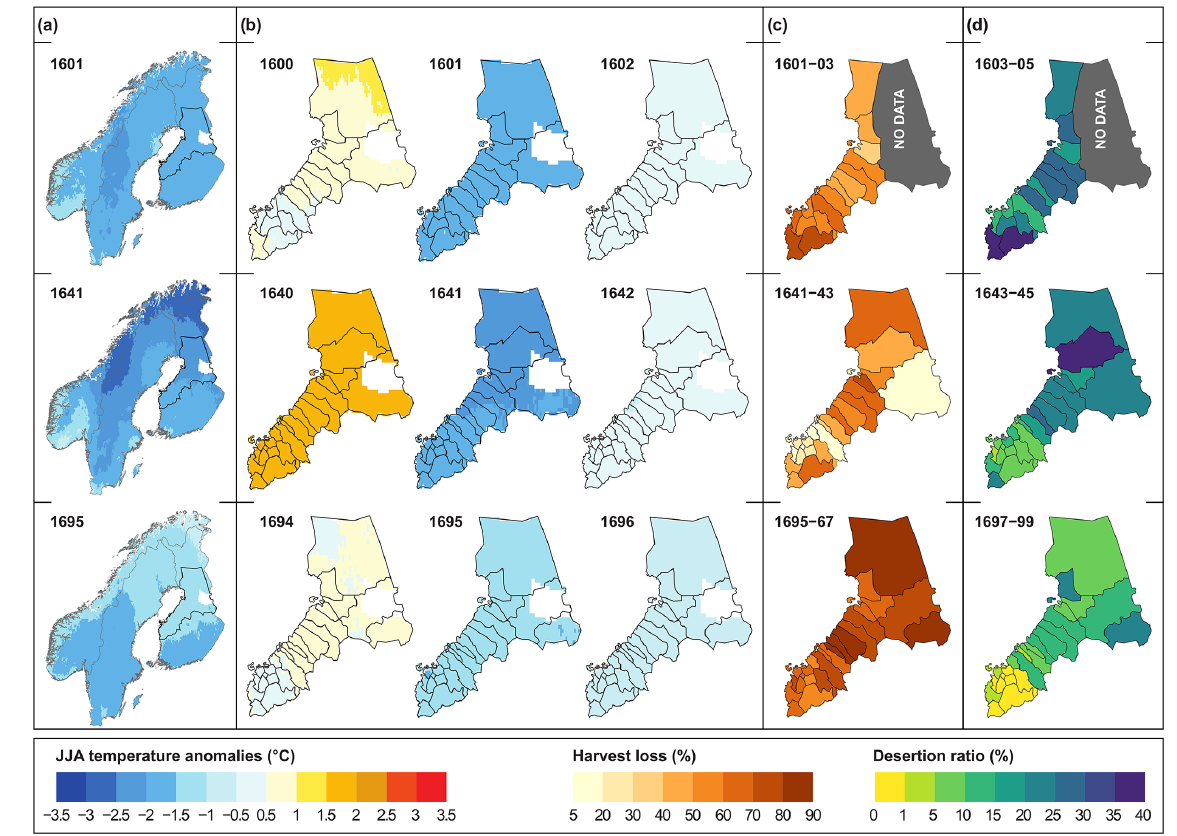
Figure 5. Spatial JJA temperature anomalies reconstructed over (a) Fennoscandia and (b) Ostrobothnia using the E-OBS 10min × 10min gridded dataset (with respect to 31-year running mean), (c) 3-year harvest loss mean (with respect to 10-year pre-crisis mean), and (d) 3-year desertion ratio mean for the cooling induced by the Huaynaputina eruption in 1601 (upper row), the Koma-ga-take–Mount Parker eruptions in 1641 (middle row), and unidentified 1695 eruption (lower